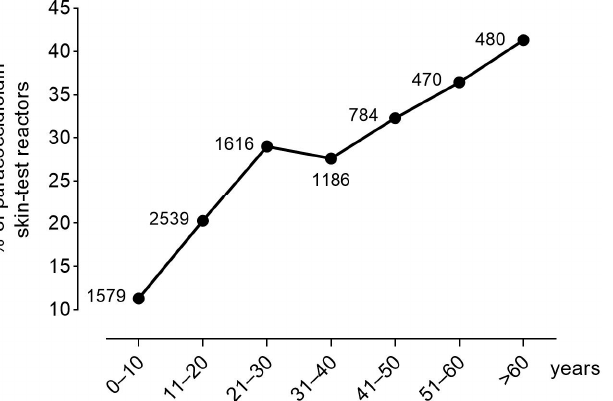
Figure 3. Percentage of paracoccidioidin skin test reactors gathered from references 18, 19, 21–25, 27, 28, 30, 32, 35, 36, 39–41, 44, and 47. The total number of persons tested for each age interval is indicated.